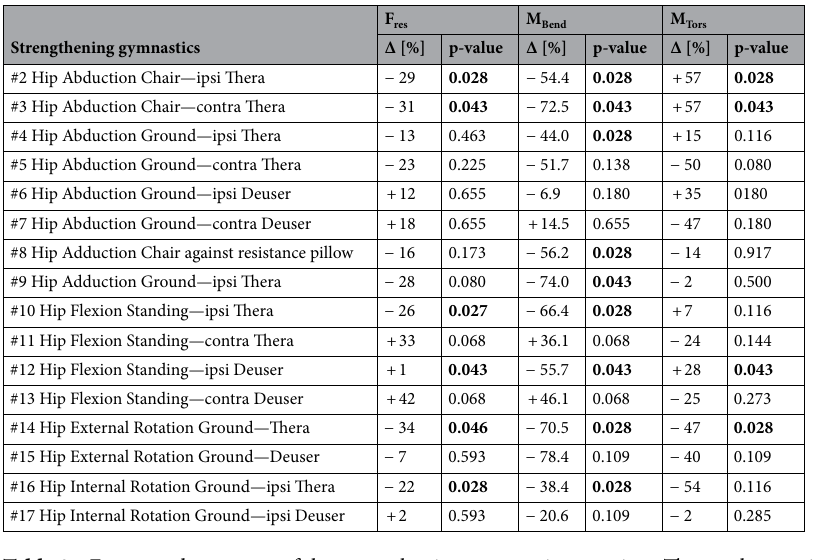
Table 3. Forces and moments of the strengthening gymnastics exercises. The results are given as delta ∆ (%) of the median peak values of the resultant force F res , bending M Bend and torsion M Tors moment of the strengthening gymnastic exercises and their variations in relation to the reference activity walking. Ipsi and contra denotes the ipsilateral or contralateral performance of the exercise with regard to the instrumented THA. Deuser and Thera refers to the used therapeutic band. Differences between the stretching gymnastic exercises and the reference activity are reported in relation to F res , M Bend and M Tors and Wilcoxon signed rank test was